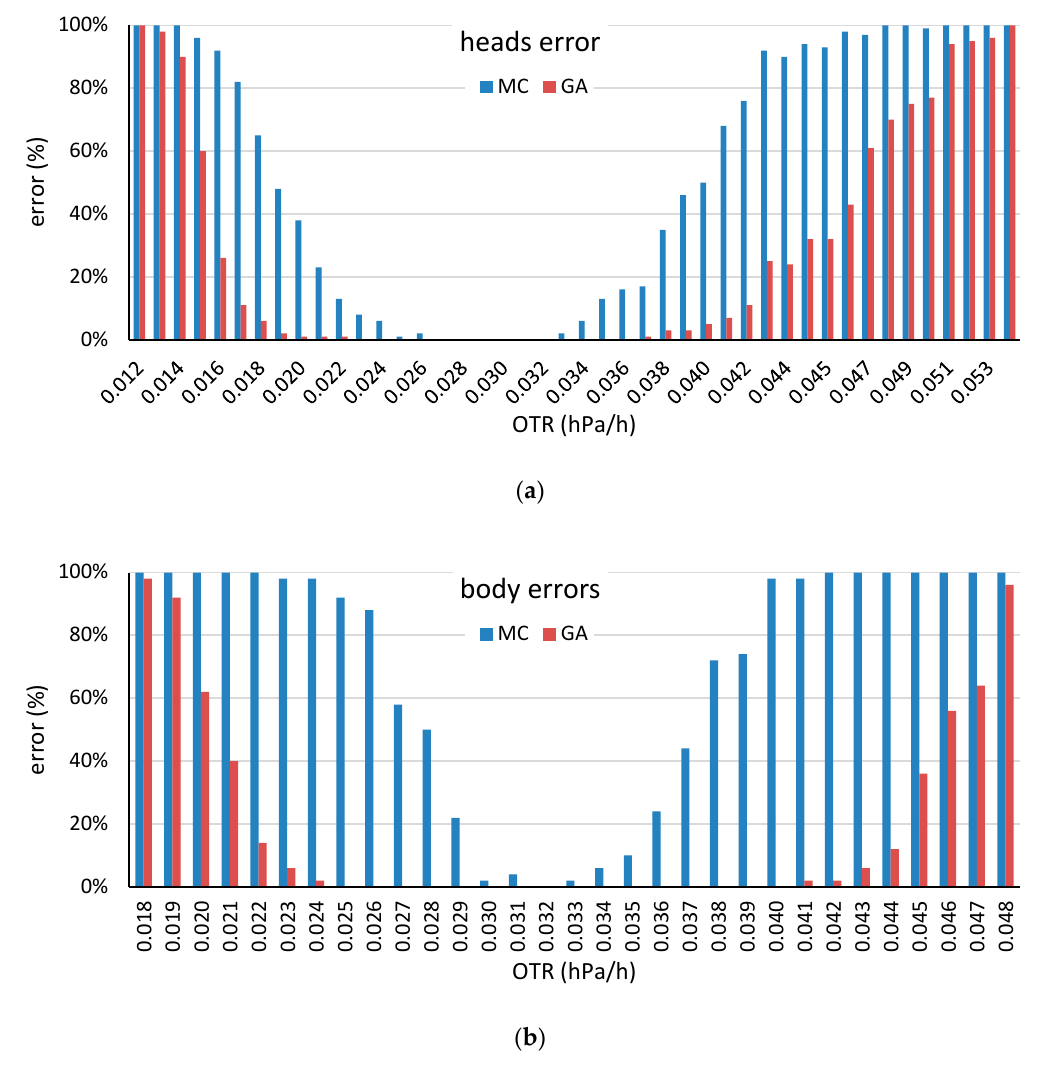
Figure 7. Error rates of the head stave ( a ) and the body stave ( b ) by selection method for the various target OTR values. A simulation was regarded as an error when the maximum iteration time was reached without identifying a head or a body barrel with the desired OTR value.